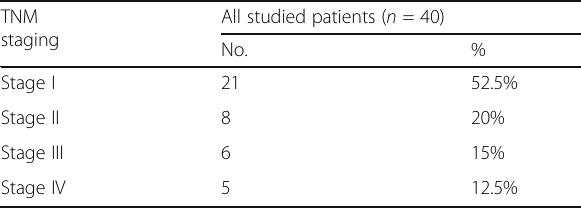
Table 4 TNM staging of HCC in all studied